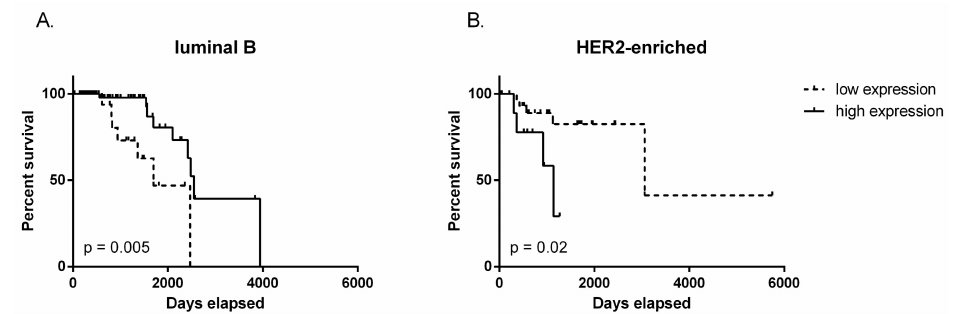
Figure 3. Disease-free survival determined by Kaplan-Meier plots and the log-rank test according to TUG1 expression. ( A ) luminal B: 25% of patients with lower and 75% of patients with higher TUG1 expression; ( B ) HER2-enriched: 75% of patients with lower and 25% of patients with higher TUG1 expression. TUG1 disease-free survival information of breast cancer patients was downloaded from the TCGA